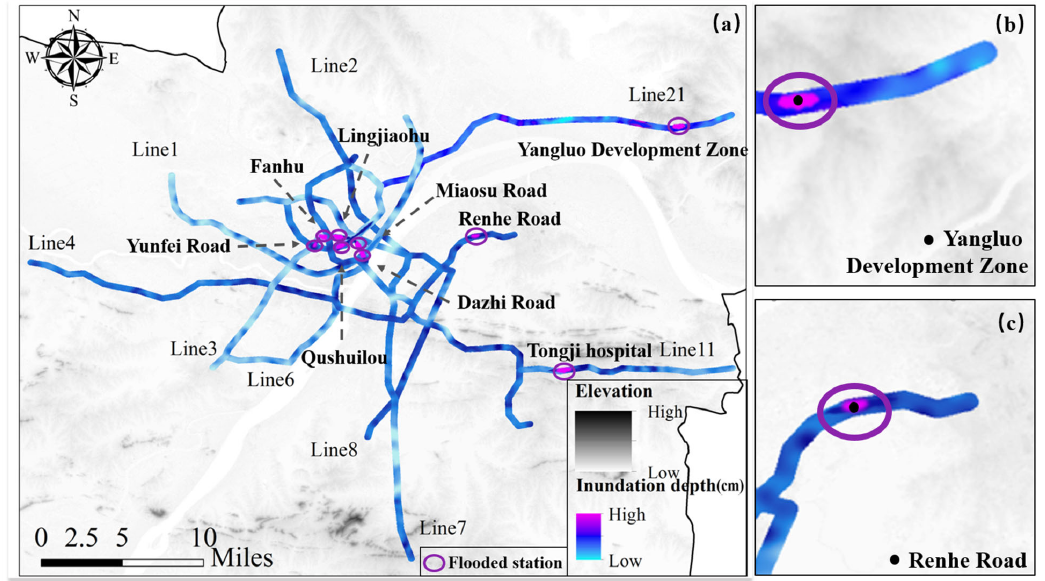
Figure 12. The prediction and identification of flood-prone stations. ( a ) Submerged water depth of the metro network. ( b ) Enlarged view of the flooded Yangluo Development Zone station. ( c ) Enlarged view of the flooded Renhe Road station.